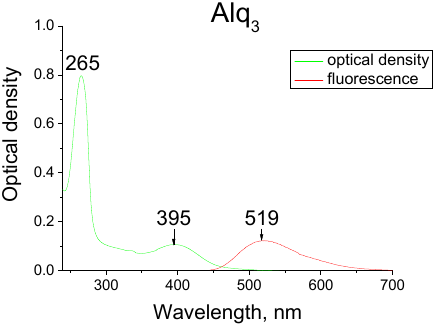
Figure 5. Absorption and fluorescence spectra of Alq 3 in solid films (thickness is several hundred nanometers).